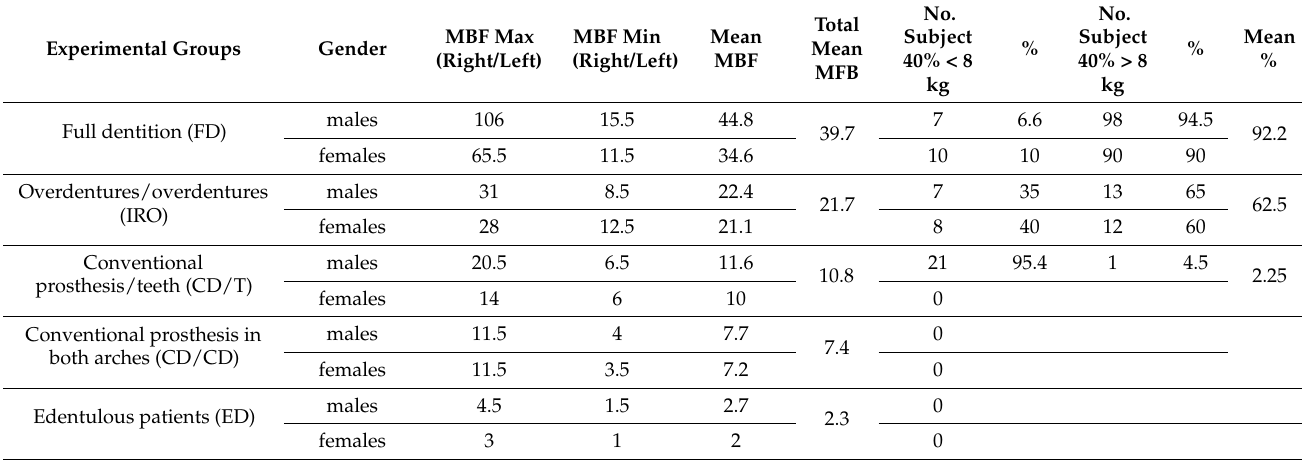
Table 1. Comparison of the means of maximum bite force (MBF) among the experimental groups. Assuming that 40% of MBF represents the real masticatory force, we have distinguished between people with 40% masticatory force greater and lower than 8 kg, an arbitrary value that can provide an indication of the type of food that can be masticated.